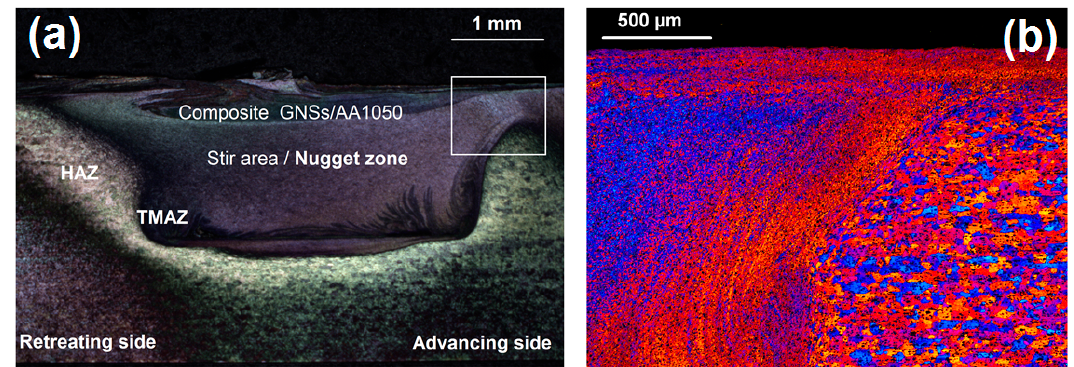
Figure 3. ( a ) Optical image of transverse section of the GNS/AA1050 nanocomposite obtained via FSP at 1120 rpm and 63 mm/min advancing speed; ( b ) enlargement of the zone delimited by the rectangle in ( a ).